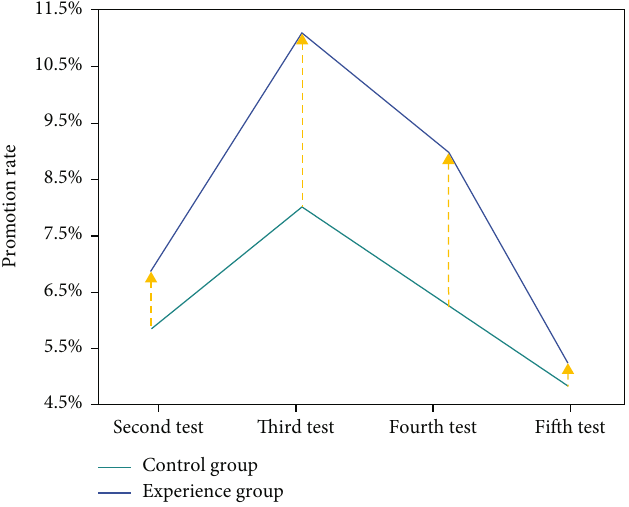
Figure 9: Comparison of the average score improvement rate of four tests between two